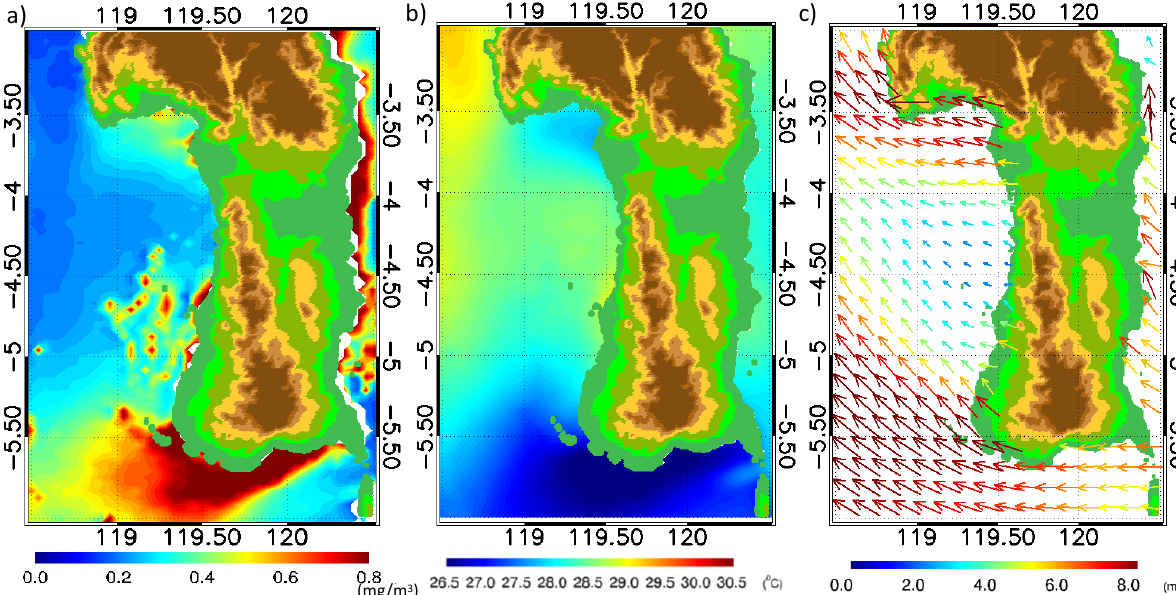
Figure 2. Spatial distribution of ( a ) Chl-a, ( b ) SST, and ( c ) surface wind along the western coast of South Sulawesi in August climatology (2007 – 2019).